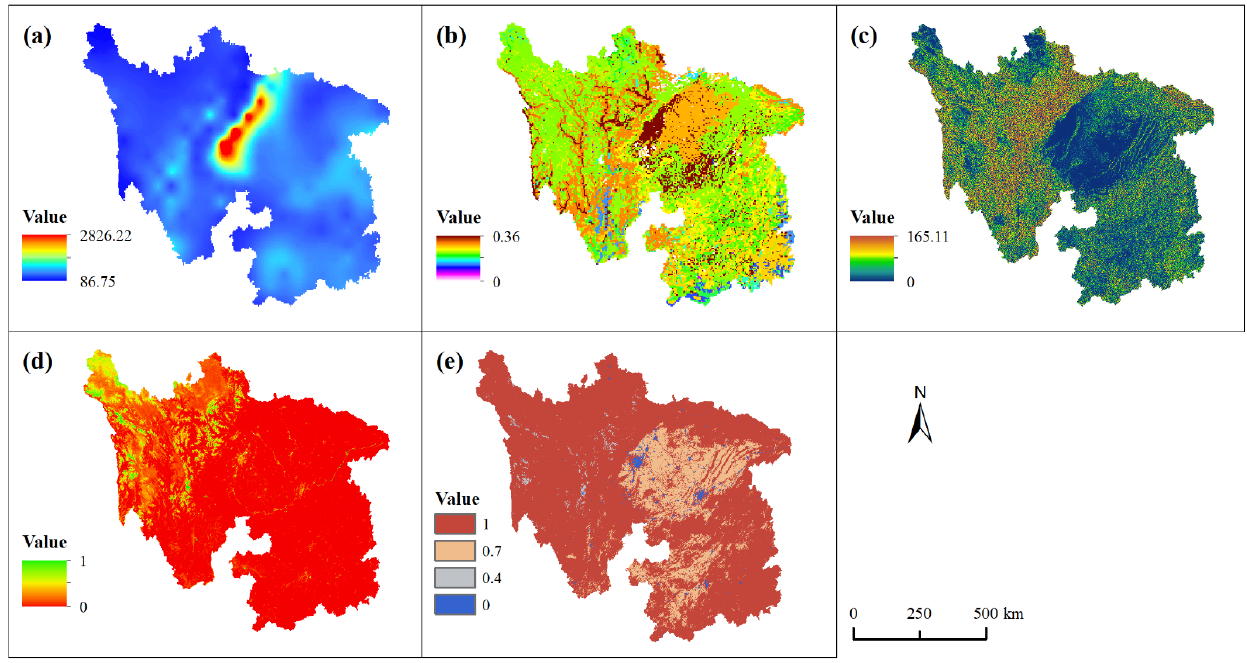
Figure 5. Spatial distribution characteristics of five soil erosion factors. ( a ) R: rainfall erosivity factor; ( b ) K: soil erodibility factor; ( c ) LS: slope length and steepness factors; ( d ) C: cover-management factor; ( e ) P: support practice factor.